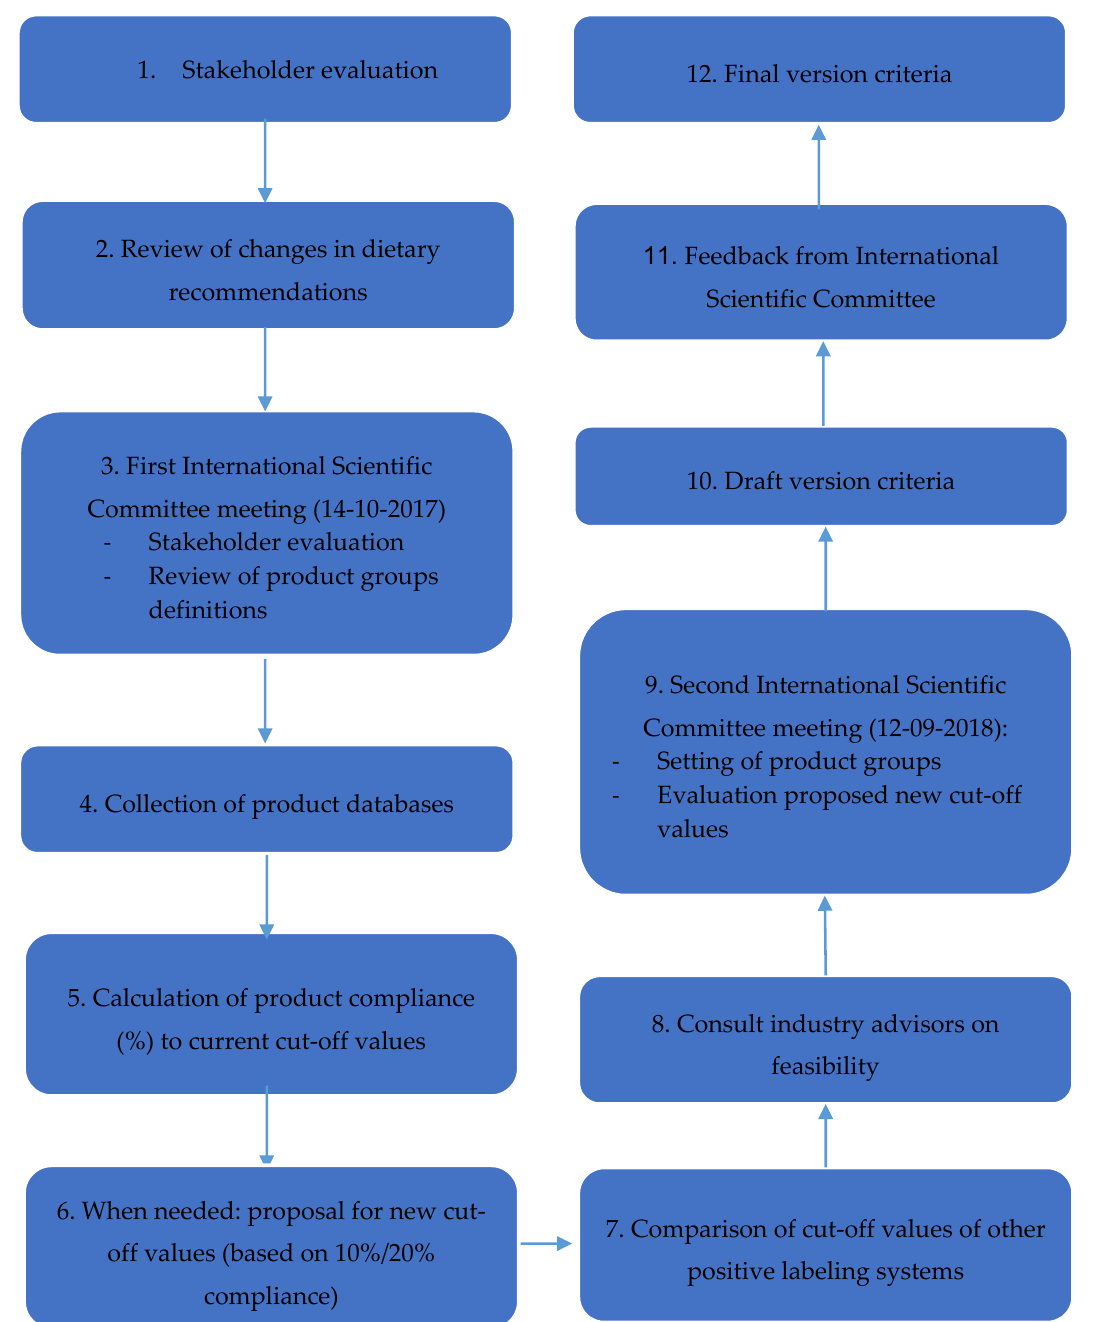
Figure 2. Flow chart of criteria revision process. September 2017–early 2019.